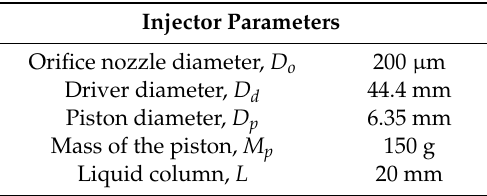
Figure 1. Schematic of the experimental setup consisted of the detonation tube and the needle-free liquid jet injector module. Table 1. Injector module